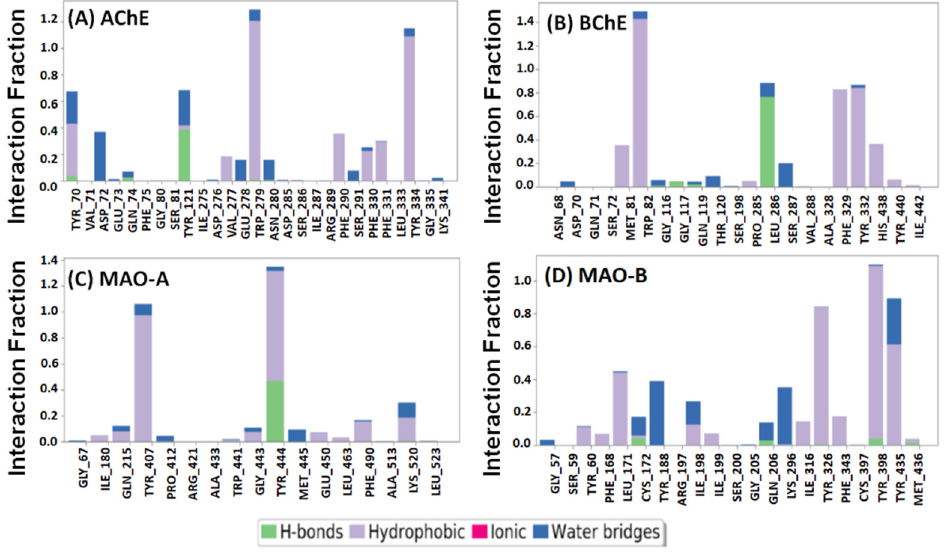
Figure 8. Interactions of F0850-4777 with ( A ) AChE, ( B ) BChE, ( C ) MAO-A, and ( D ) MAO-B.